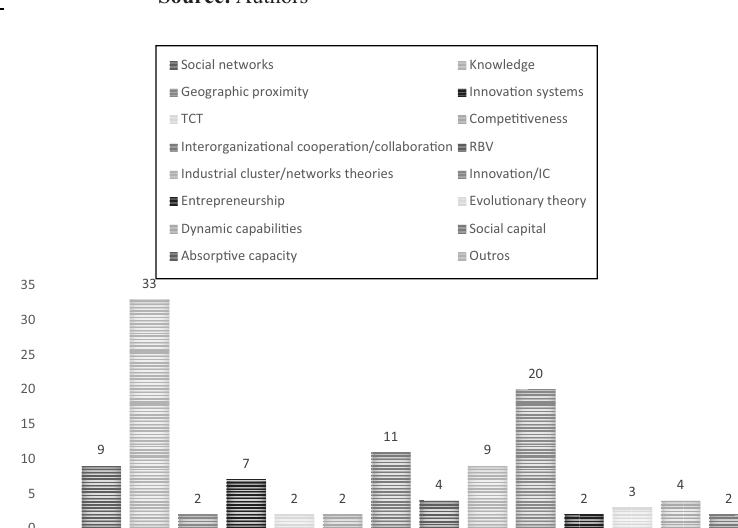
Figure 7. Innovation capability